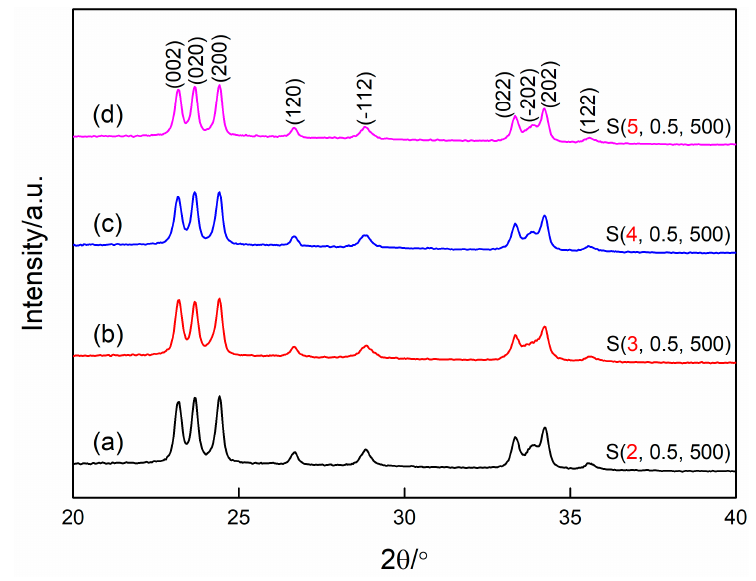
Figure 2. X-ray diffraction patterns of WO 3 films prepared at different aging times. ( a ) 2 h, ( b ) 3 h, ( c ) 4 h, ( d ) 5